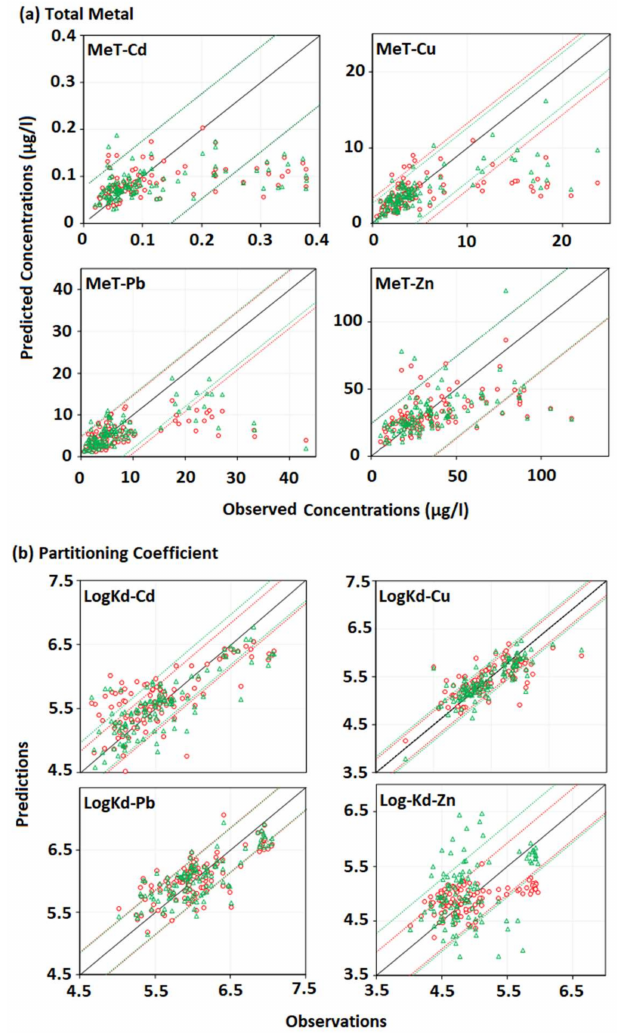
Figure 4. Predicted versus observed ( a ) total concentrations: MeT ( b ) Partitioning coefficients (log based: Log K d ) of Cd, Cu, Pb and Zn based on multi-linear regression (MLR) (circles) and principle component regression (PCR) (triangles). Dotted lines indicate the 1-standard deviation prediction interval. The solid lines correspond to the bisector